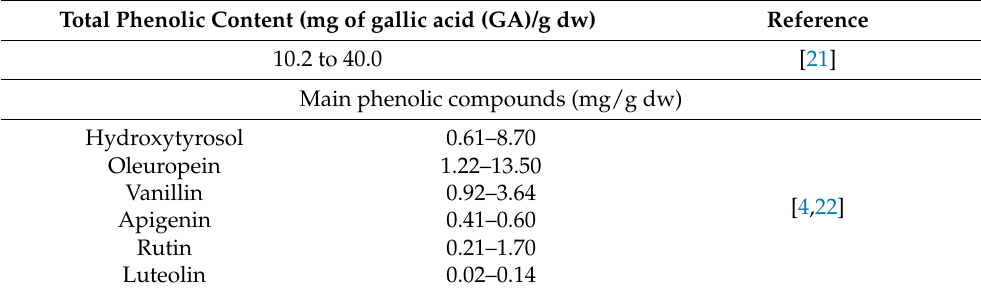
Table 1. Total phenolic content and the main phenolic compounds of olive pomace.